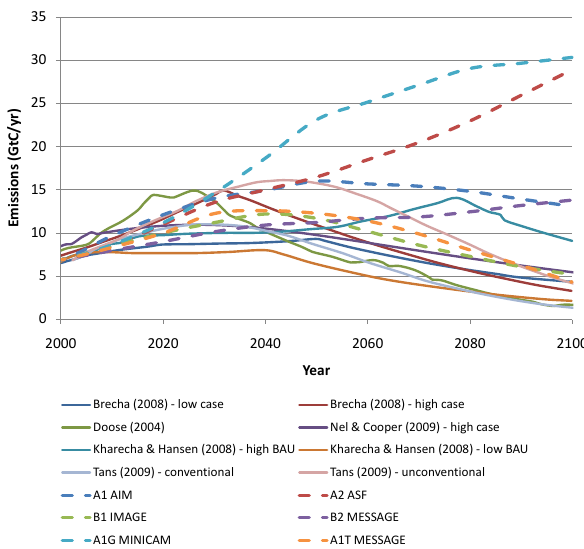
Fig. 2. Comparison between various published projections for emis- sions due to fossil fuel production against the RCP scenarios from Moss et al. (2010). The faint grey lines correspond to the 40 SRES scenarios presented in Nakicenovic and Swart (2000).